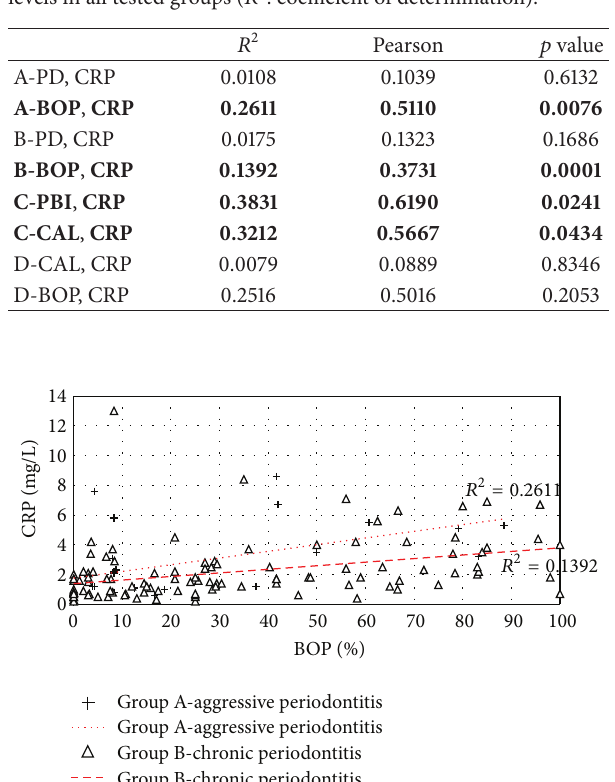
Table 3: Statistical comparisons of clinical parameters and CRP levels in all tested groups ( 𝑅 2 : coefficient of determination).